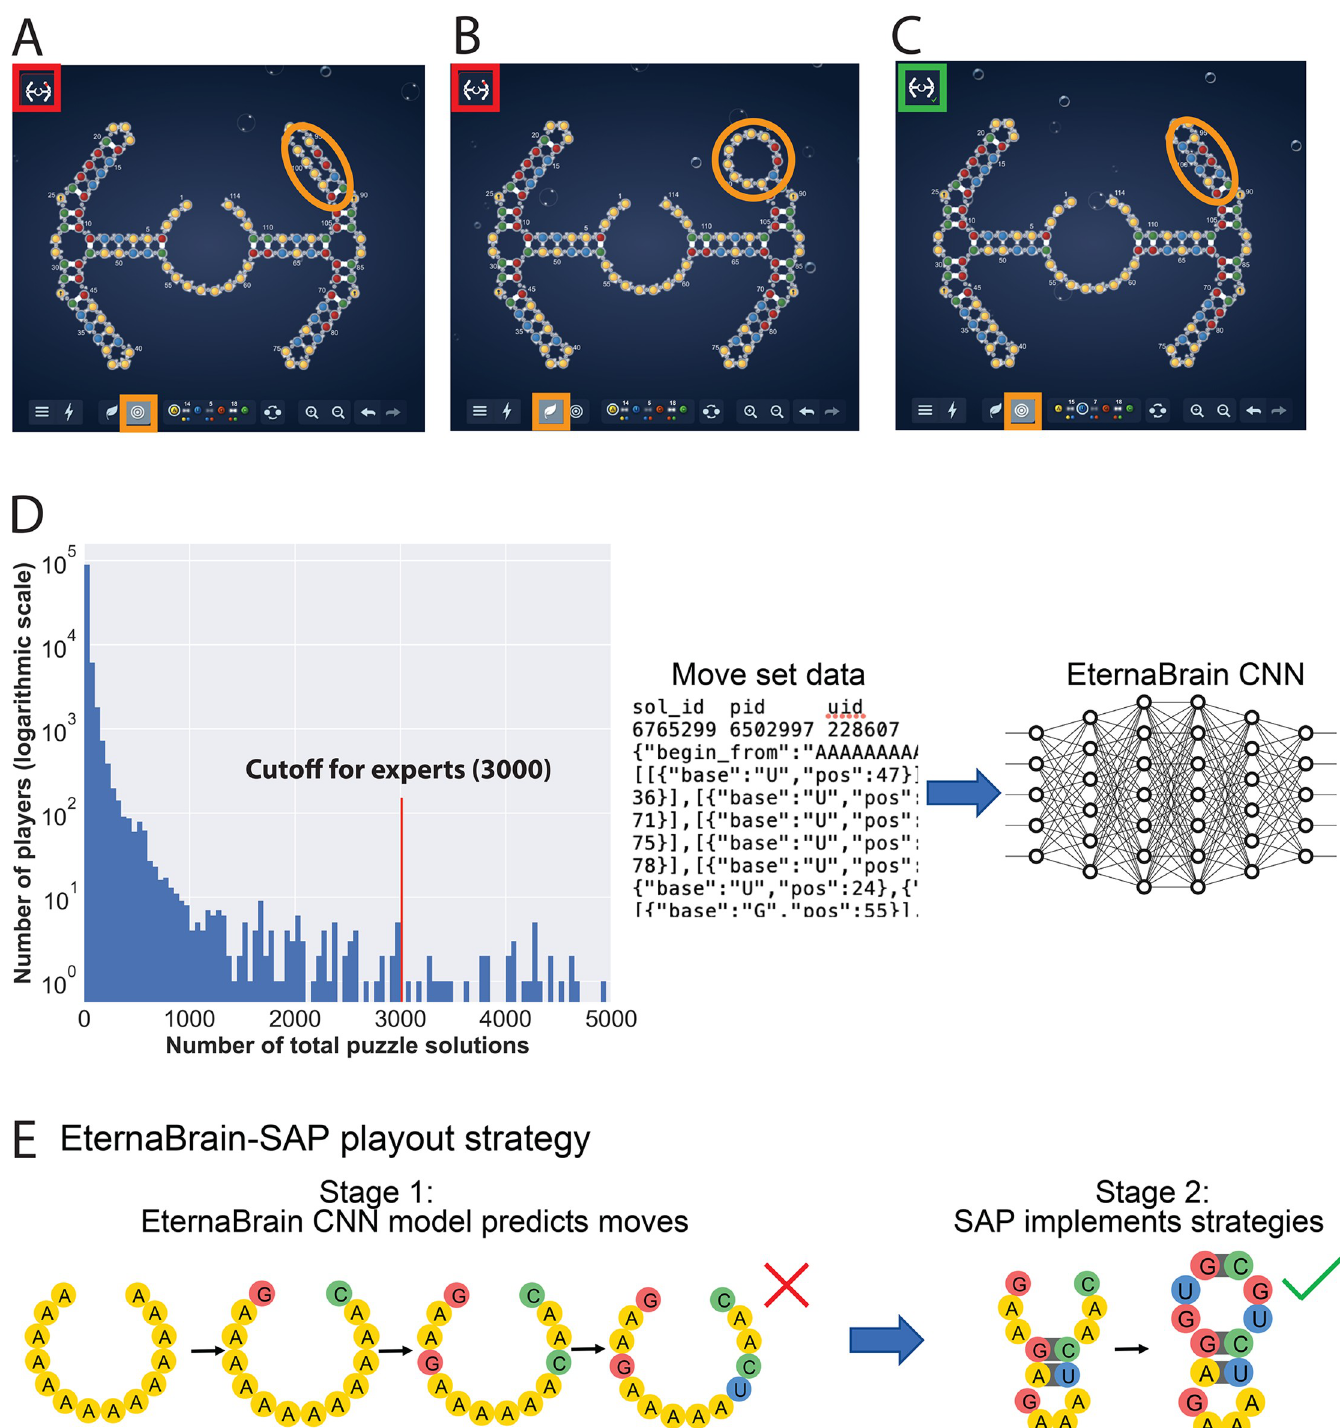
Fig 1. Eterna and EternaBrain. (A-C) Puzzle-solving interface presented to human players of Eterna including the state of the puzzle (whether it is solved or not) in the top left corner (red/green outline), the puzzle itself (in the middle), and the toolbar (bottom) with which the players can mutate the RNA sequence to make it fold into the desired state; yellow, blue, red, and green symbols represent A, U, G, and C nucleotides. (A) The desired target structure for the RNA molecule, as indicated by the bullseye in the bottom left (orange highlight). (B) Nature mode, as indicated by the leaf in the bottom left (orange highlight), gives the predicted minimum free energy structure for the current sequence. Since the bases in the top right should be paired with each other (orange circle), this puzzle is not yet folding correctly; this status is shown by the red indicator in the top left corner. (C) The solved puzzle. The nature-mode structure matches the target structure, and the indicator in the top left corner